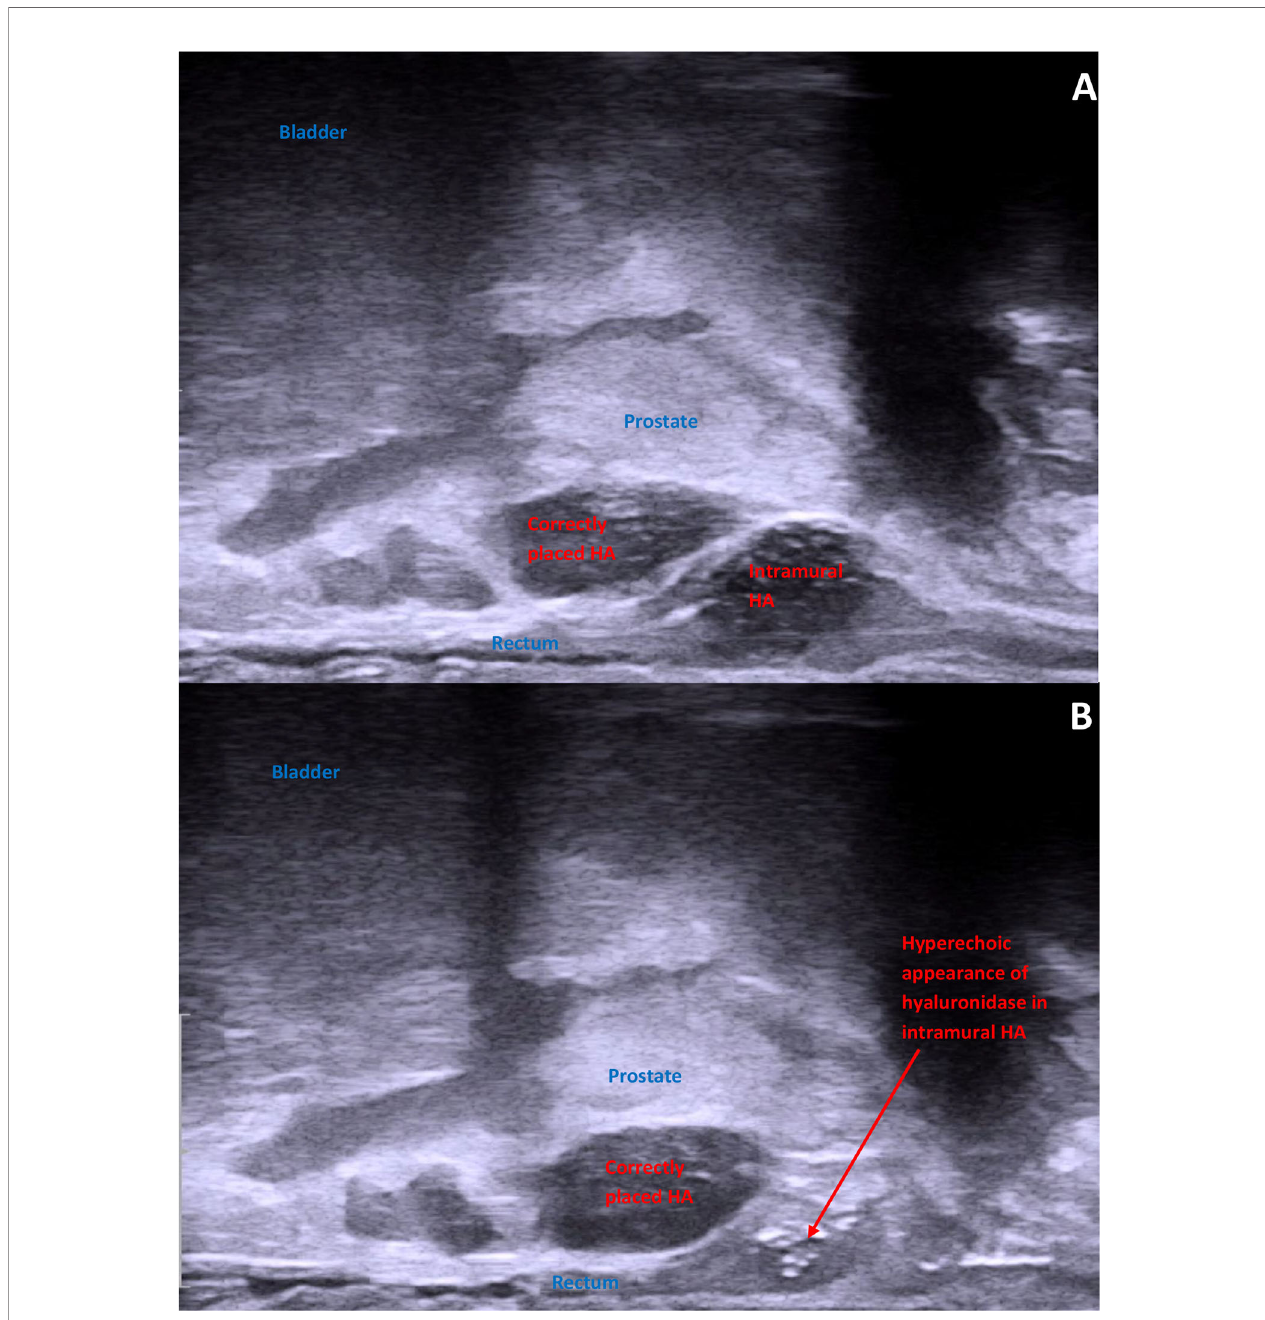
FIGURE 3 | Intraoperative transrectal ultrasound images demonstrating (A) the misinjected HA in the rectal wall and (B) the hyaluronic acid immediately after injection into the intramural NASHA (now